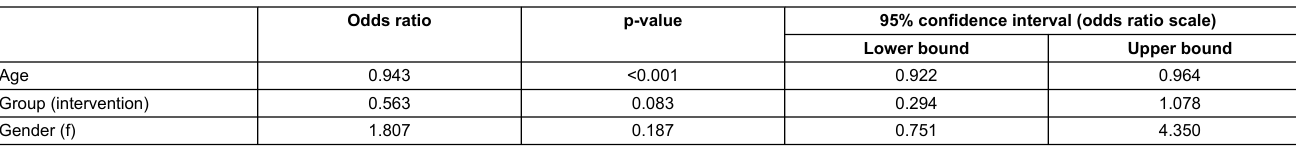
Table 3: Coefficients for all patients.